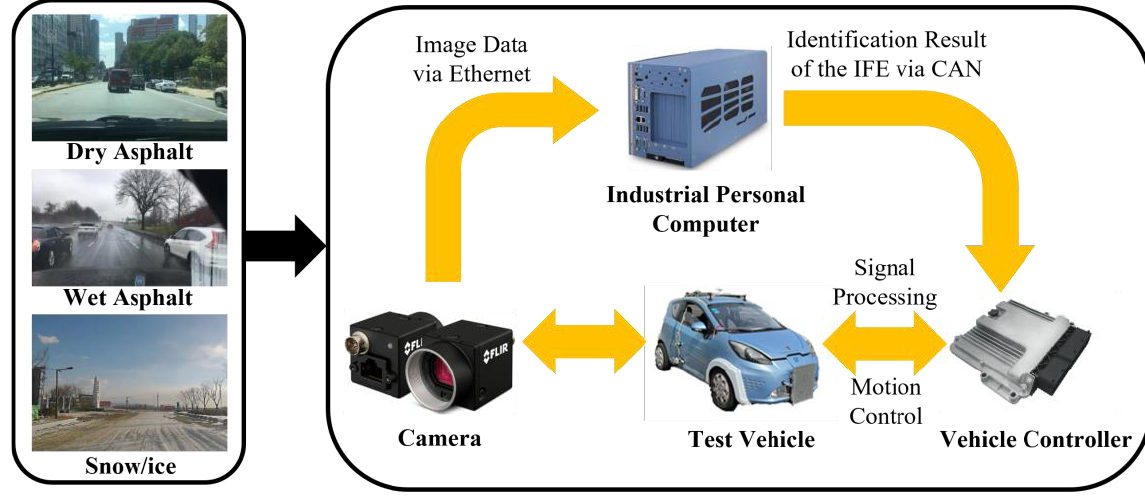
Figure 12. Experimental test platform.